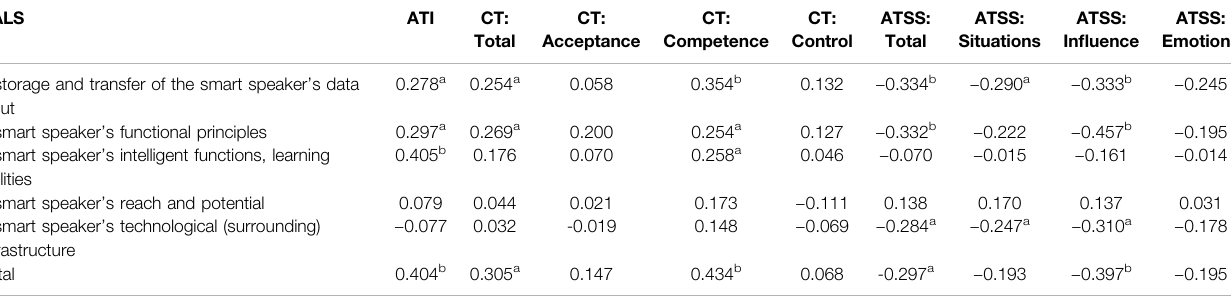
TABLE 7 | Correlations between CALS subscales and technology-related competencies and attitudes. CALS ATI CT: